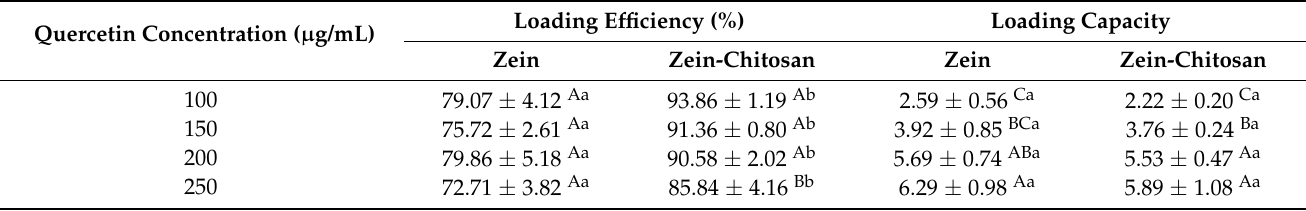
Table 2. Loading efficiency and loading capacity of quercetin in hollow zein and zein-chitosan particles. Quercetin Concentration ( µ